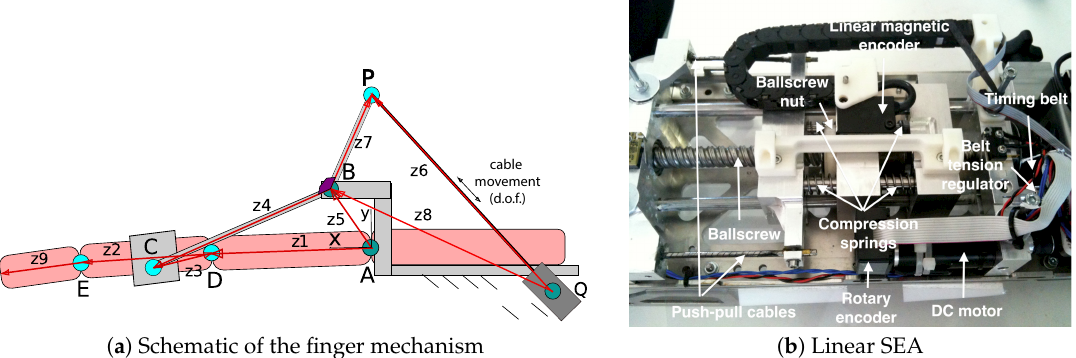
Figure 4. Details of the slave orthosis. ( a ) Schematic of the whole mechanism (gray-black) connected to the finger (pink), which shows the rigid links, the revolute joints and the slider (point Q ). Joints with a darker color are fixed to the frame. ( b ) Identification of the components included in the linear series elastic actuator